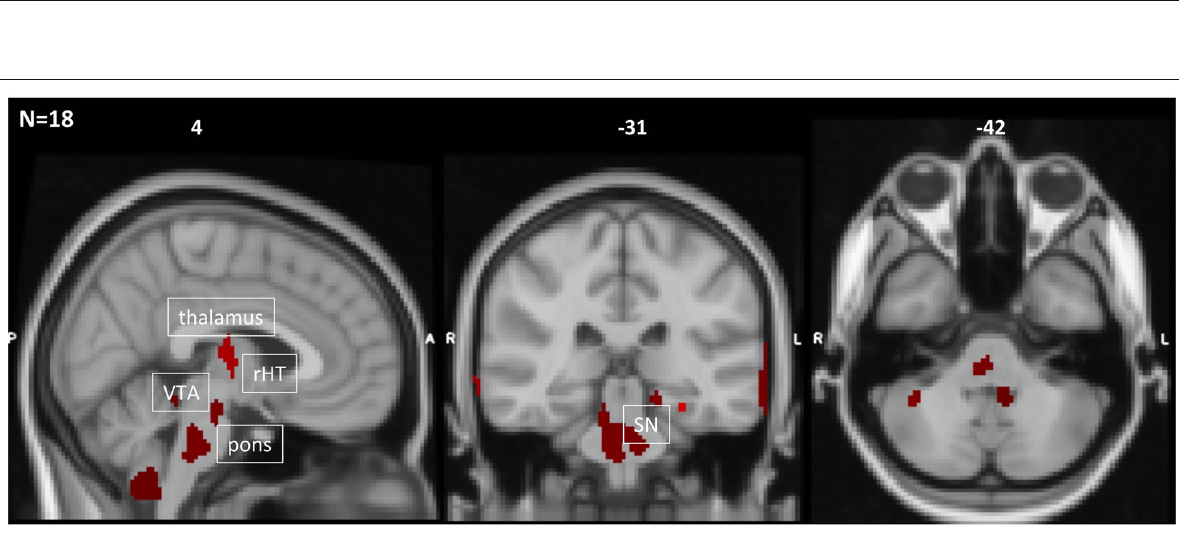
Fig. 5 Exploratory results from local decreases in CBF across all CH patients following GONB at more relaxed initial cluster-forming height threshold. Data included four CBF maps per patient and session. All clusters are significant at p < 0.005 (uncorr). rHT = right hypothalamus; VTA = ventral tegmental area; SN = substantia nigra. Coordinates are represented in MNI